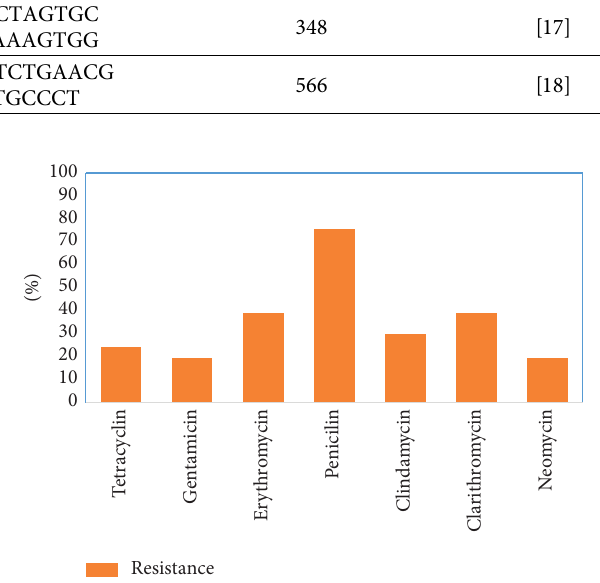
Figure 1: Antibiotic resistance patterns of C. minutissimum in the present study.